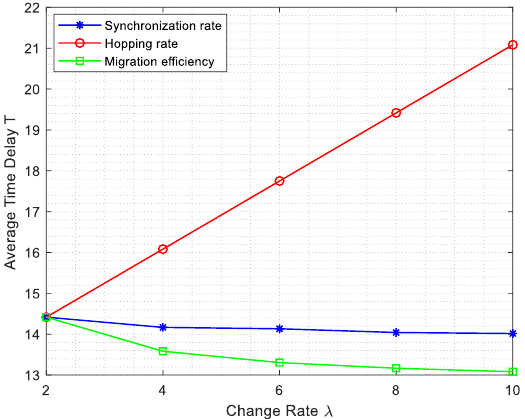
Figure 12. Effect of change rate on Average Time Delay.